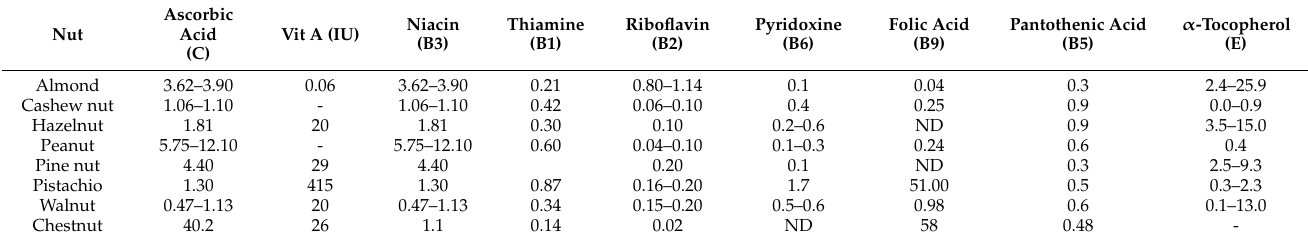
Table 2. Vitamin contents (mg/100 g) of selected nuts (source: [10,11,19,31–33]).